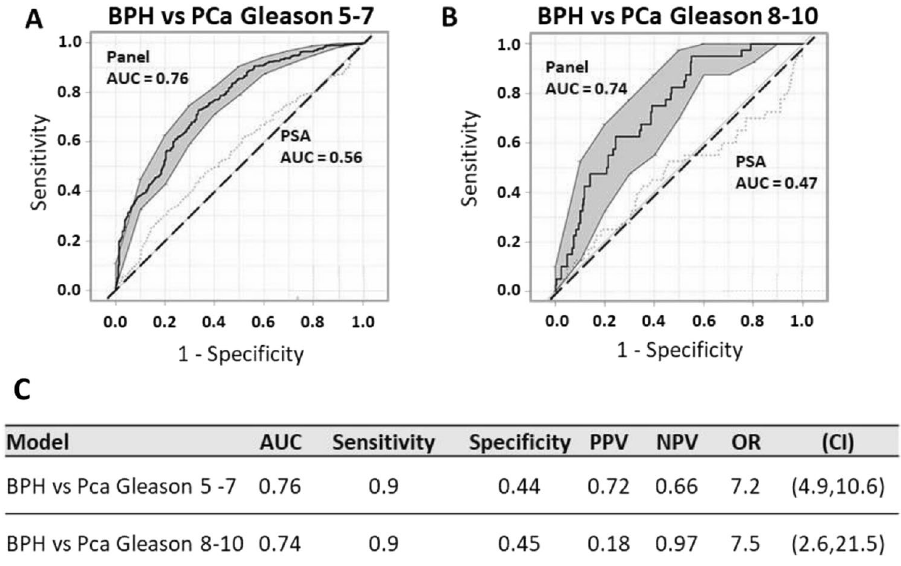
Figure 4. Prostate Cancer Biomarker Panel Differentiates Lower Urinary Tract Symptoms/Benign Prostate Hyperplasia (LUTS/BPH) from Prostate Cancer (PCa) in Patients with Intermediate and High Gleason Score. ( A ) Receiver operator characteristics (ROC) curve for prostate cancer biomarker panel demonstrates better performance in differentiating patients with LUTS/BPH from PCa compared to PSA alone in patients with an intermediate Gleason score (5–7). Area under the curve (AUC) for the panel is 0.76 versus PSA alone 0.56. Shaded grey regions indicate standard error. ( B ) Receiver operator characteristics (ROC) curve for prostate cancer biomarker panel demonstrates better performance in differentiating patients with LUTS/BPH from PCa compared to PSA alone in patients with a high Gleason score (8–10). Area under the curve (AUC) for the panel is 0.74 versus PSA alone 0.47. Shaded grey regions indicate standard error. ( C ) Diagnostic performance (AUC), sensitivity, specificity, positive predictive value (PPV), negative predictive value (NPV), odds ratio (OR), and 95% confidence interval (CI) of the OR for each